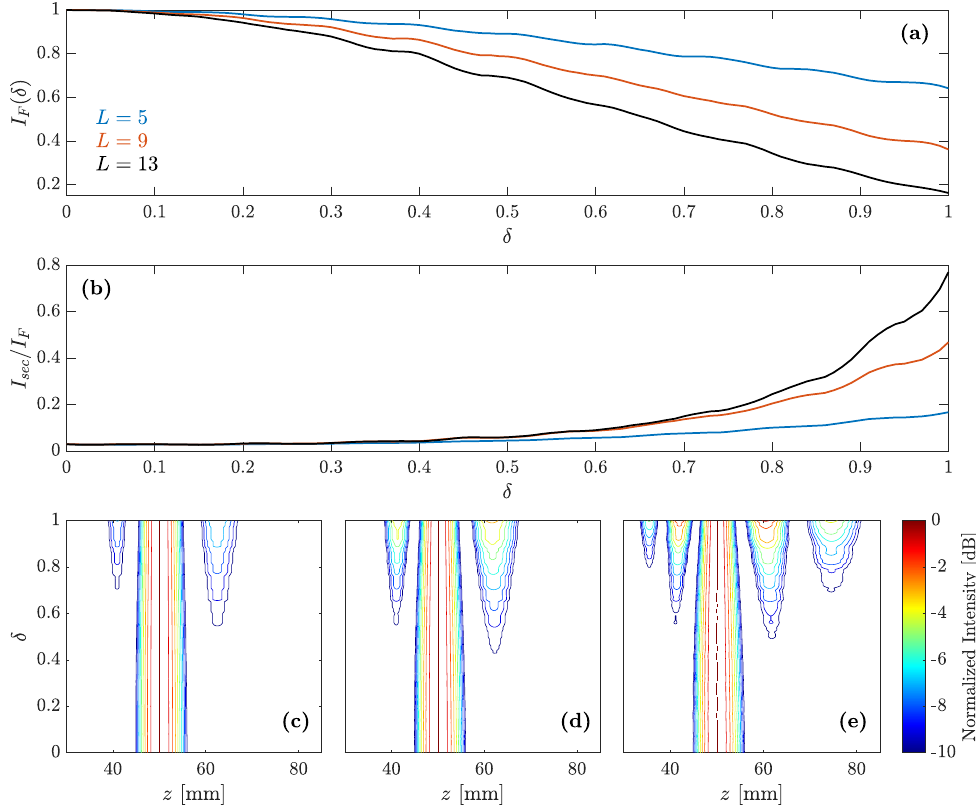
Figure 7. ( a ) Intensity of the main focus normalized to the non-predistortion case. ( b ) Intensity of the higher secondary focus normalized to the focal intensity. Both ( a , b ) are depicted as functions of δ for L = 5, L = 9, and L = 13. ( c – e ) Focusing profile contour maps as a function of δ for L = 5 ( c ), L = 9 ( d ) and L = 13 ( e